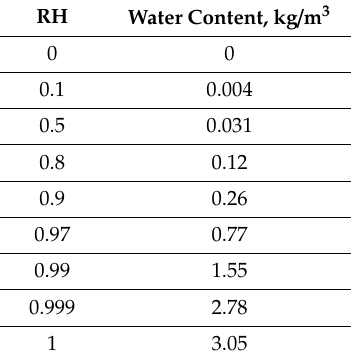
Table A6. Moisture storage function.